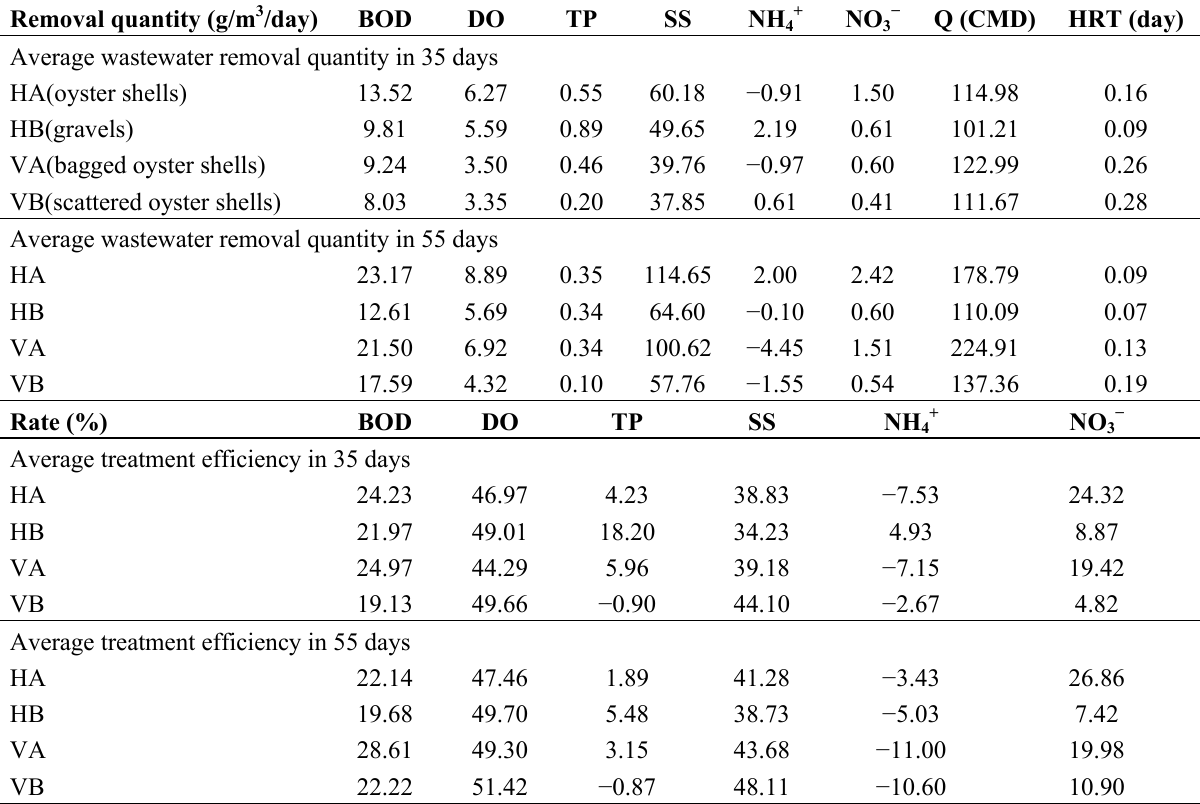
Table 3. Average wastewater removal quantity (g/m 3 /day) and average treatment efficiency (%) and hydraulic properties of the four study wetlands calculated at 35-day and 55-day operation period in the present